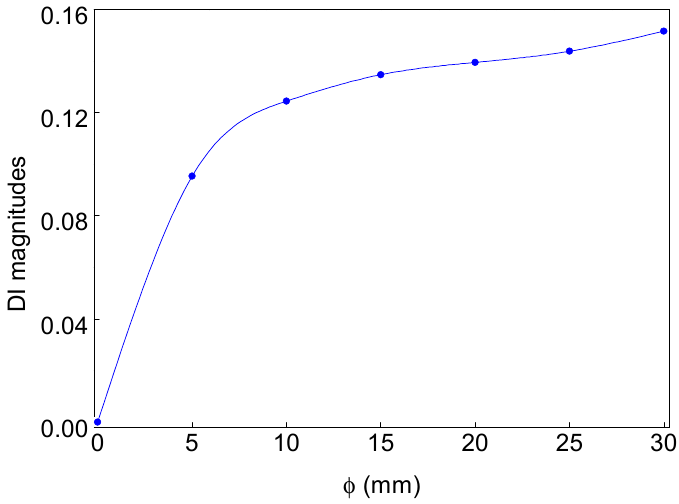
Figure 14. Change in debond index with the variation in debond size ( φ ).